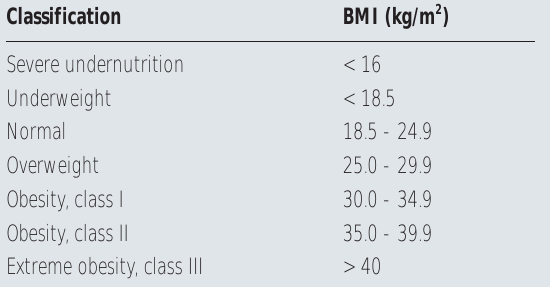
TABLE 2.1. THE BODY MASS INDEX (BMI) – A MEASURE OF THE RISK OF UNDERNUTRITION AND